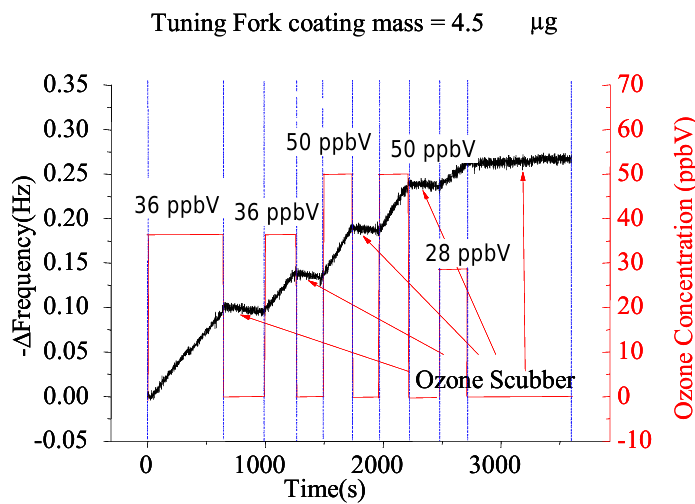
Figure 2. Response of a 4.5 μ g polybutadiene coated tuning fork towards alternate low ozone concentration and ozone-free air exposures (alternate time segments are separated in the plot using blue lines). Low ozone concentrations were generated with the UV source, and ozone-free air samples were generated with air samples passing through an ozone scrubber. The exposure was managed through a switching valve, and the actual concentration of ozone was monitored on-line at the outlet of the QTF cell. The slope of the frequency response increased when the sensor was exposed to ozone, and a positive slope (- Δ f/ Δ t) change is indicative of increasing ozone concentrations levels. The response was wirelessly assessed from the device by using a Bluetooth ® -enabled laptop.